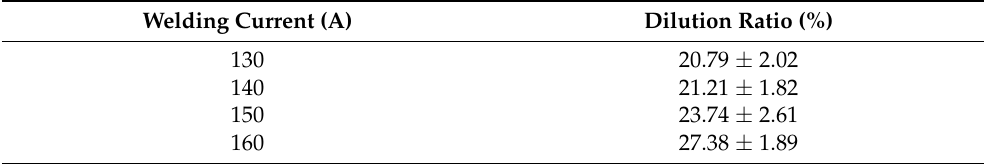
Table A1. Dilution ratio of the Cu35Ni25Co25Cr15 HEA coatings deposited under different welding